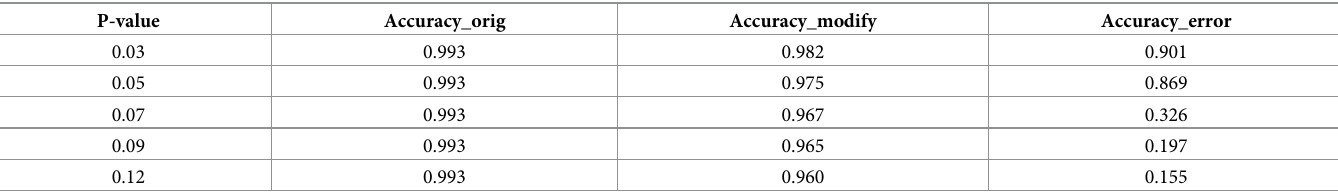
Table 3. Comparison of prediction accuracy of different algorithms.